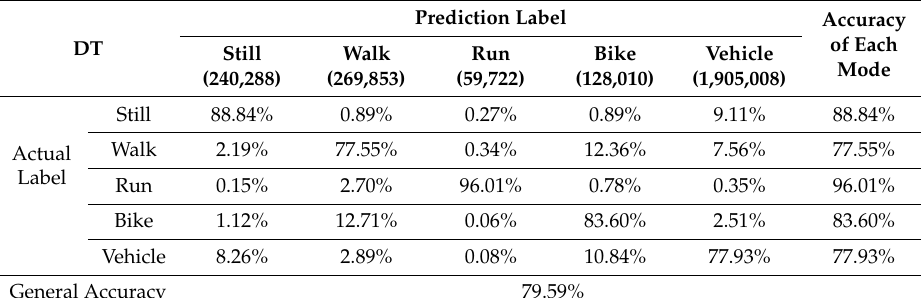
Table 5. Confusion matrix K-nearest neighbor with the proposed features.